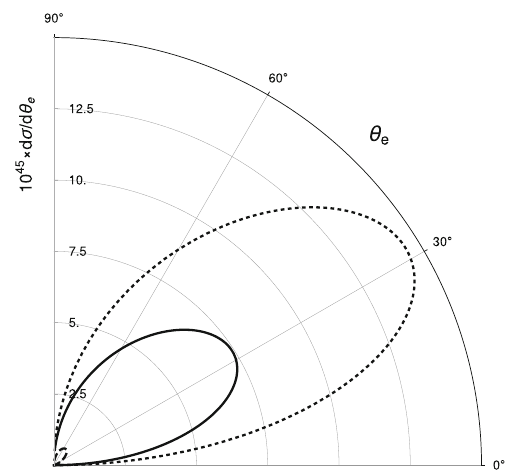
Fig. 7 Dirac (or Majorana) ν e with V – A interaction, ˆ η ν · ˆ q = − 1, E ν = 1 MeV : plot of d σ/ d θ e as a function of θ e for different values of θ 1 ; dotted line for θ 1 = 0; solid line for θ 1 = π/ 2; dashed line for θ = π 1 Fig. 6 Superposition of LC ν e s with RC ones in presence of non- (Φ ) asafunction standardcouplingswith ˆ η ν ·ˆ q = − 0 . 95:plotof A θ max e of θ e for the case of V – A with S R when E ν = 1 MeV , φ ν = π/ 4;left column for Dirac ν e , right column for Majorana ν e ; upper plot for θ 1 = 0 . 1; middle plot for θ 1 = π/ 2; lower plot for θ 1 = π − 0 . 1; solid line | = 0 . 3, θ = 0; dotted line for | c R | = 0 . 3, θ = π/ 4; for | c R S , R S , R S S | = 0 . 3, θ = π/ 2 dashed line for | c R S , R S